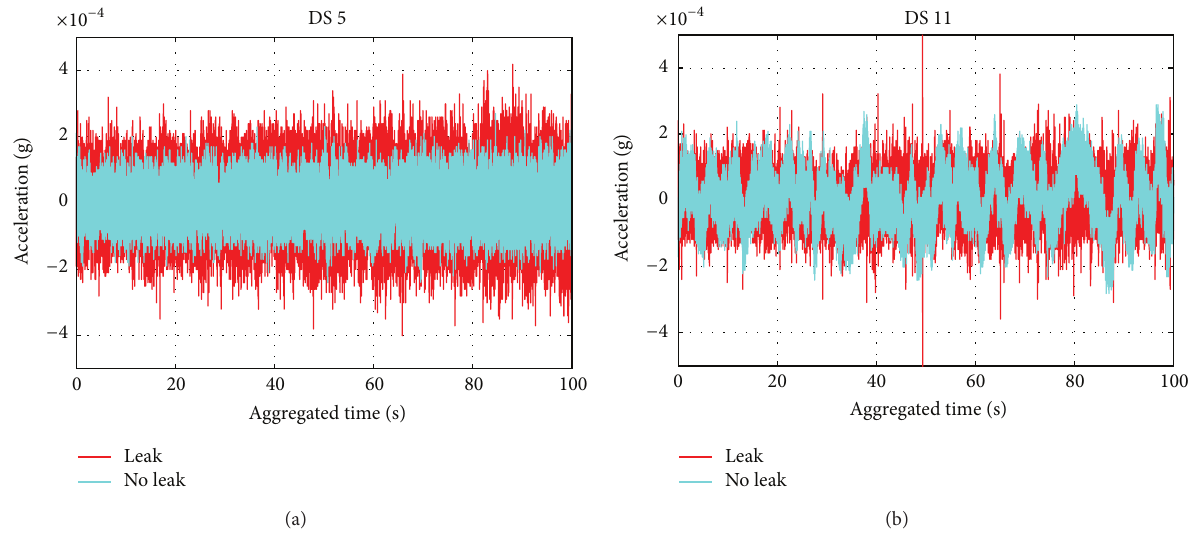
Figure 6: Aggregated time histories of the reduced datasets obtained from (a) nights #2 (leak) and #3 (no leak) of DS 5 and (b) nights #2 (leak) and #8 (no leak) of DS 11.